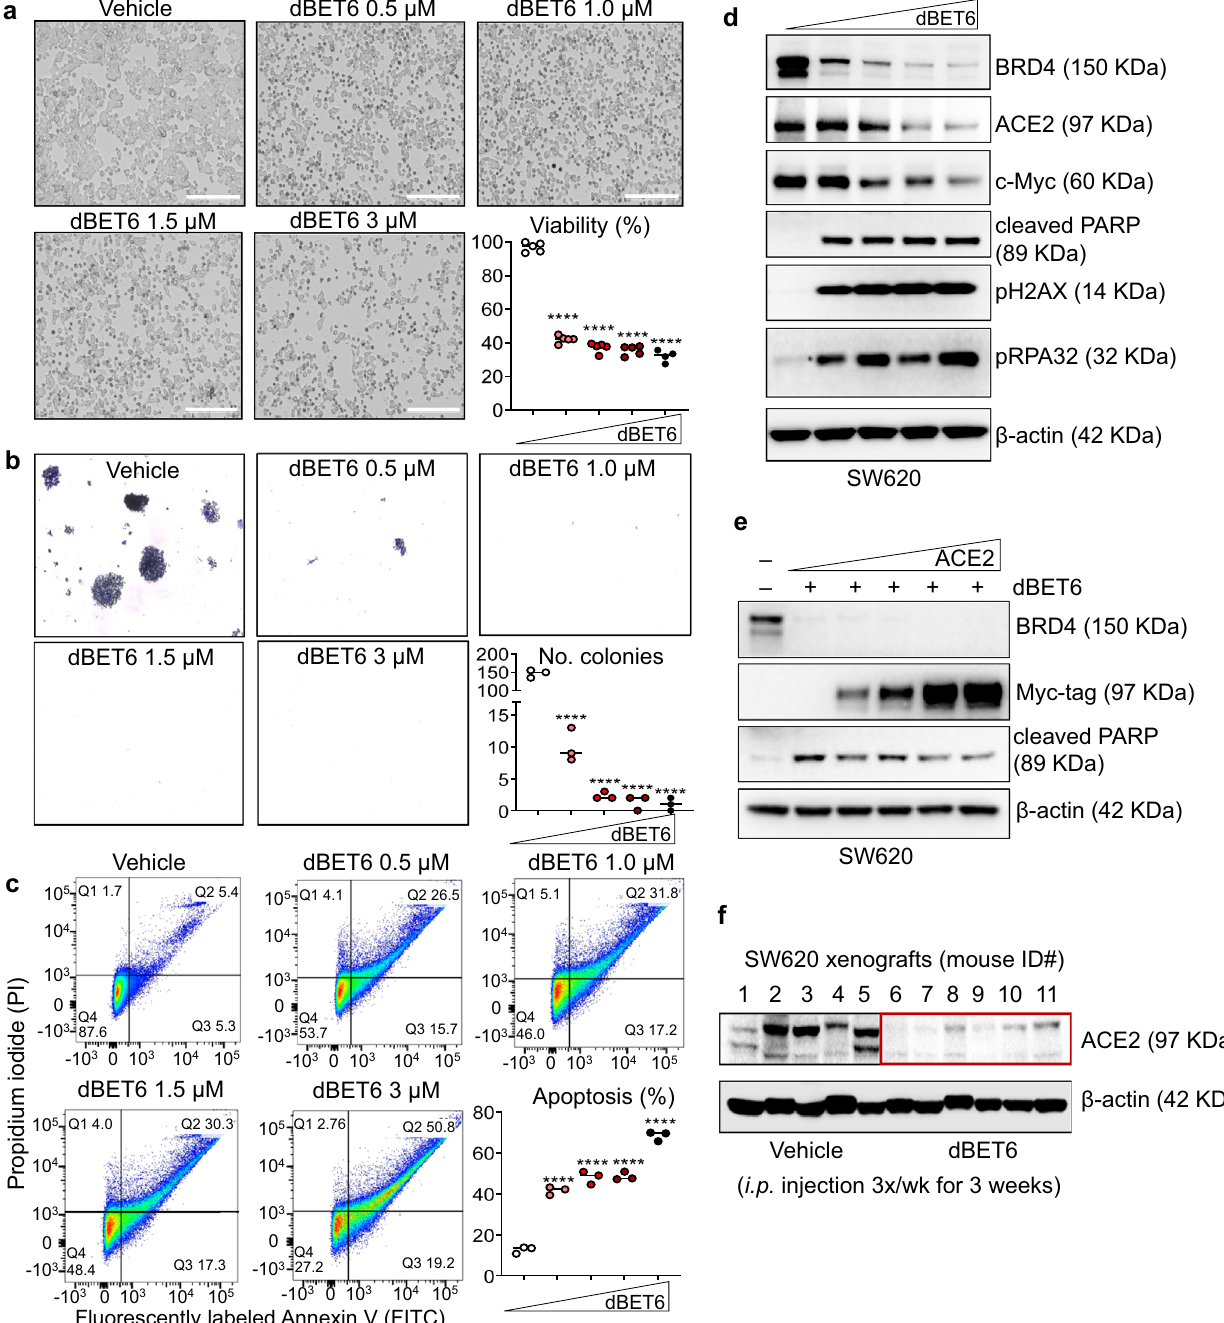
Fig. 4 Pharmacologic inhibition of BRD4 depletes endogenous ACE2 in colon cancer cells while reducing cell viability and increasing apoptosis. a Representative images of SW620 cells 48 h after treatment with BRD4 antagonist dBET6; scale bar = 200 μ m. The associated cell viability data were obtained from the CCK8 assay at 48 h. b Representative images and quanti fi cation from the colony-formation assay at 48 h. c Apoptosis quanti fi ed at 48 h by FACS analysis. d Cell lysates from panel a immunoblotted for target proteins; wedge symbol = 0, 0.5, 1, 1.5 and 3 μ M dBET6. e Immunoblotting of SW620 cells mock-transfected ( – ) or transiently transfected with Myc-tagged ACE2 ± 1 µM dBET6 for 48 h. Wedge symbol = 0, 0.5, 1, 2 and 3 μ g Myc-tagged ACE2. f Nude mice received vehicle or dBET6 at a dose of 7.5 mg/kg body weight by i.p. injection, 3 times per week for 3 weeks ( n = 5 – 6 animals/group). Tumor growth inhibition and molecular target modulation, including BRD4 protein loss, were reported previously 7 . The biobanked SW620 cell lysates exhibited reduced ACE2 protein expression after dBET6 treatment in vivo (red box). In a – c , difference between means from n = 3 replicates; **** p < 0.0001 by Student ’ s t test vs. vehicle control. GraphPad Prism